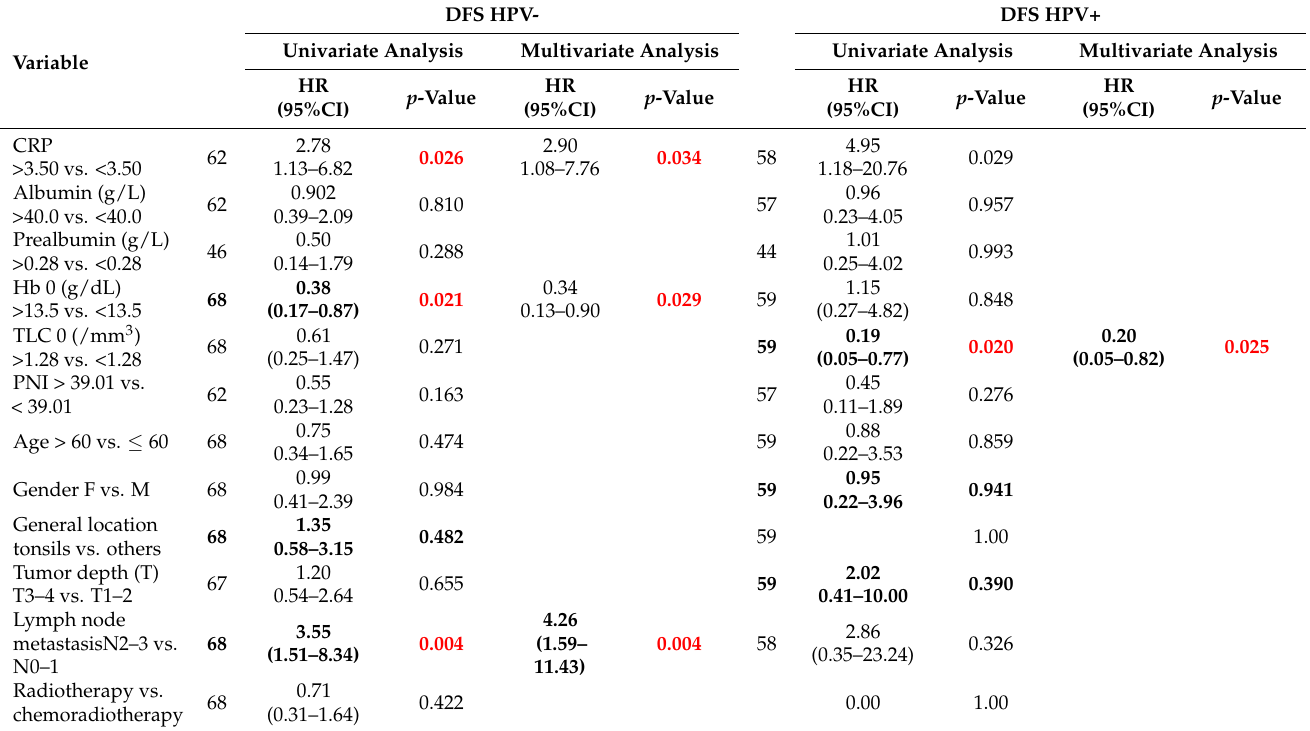
Table 7. Disease-free survival (DFS) in HPV-/HPV+ patients: univariate and multivariate